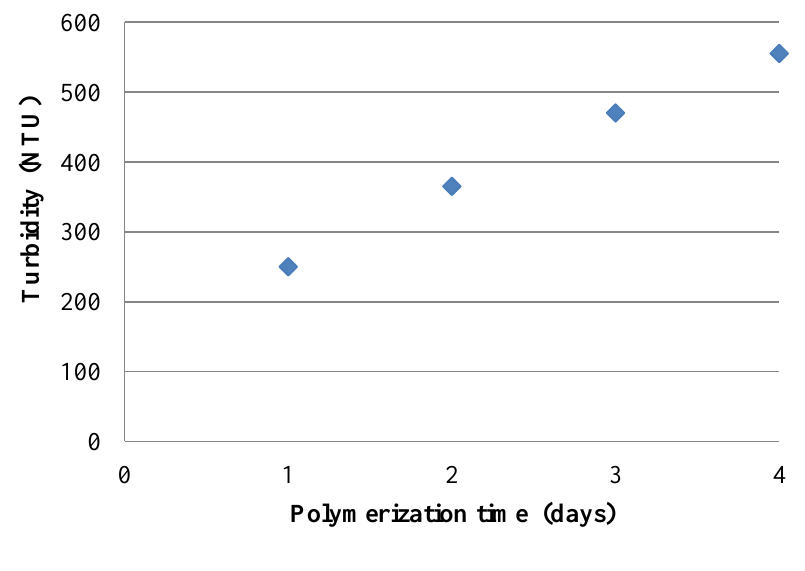
Figure 4. Turbidity values versus polymerization time for a sample containing 10 mg